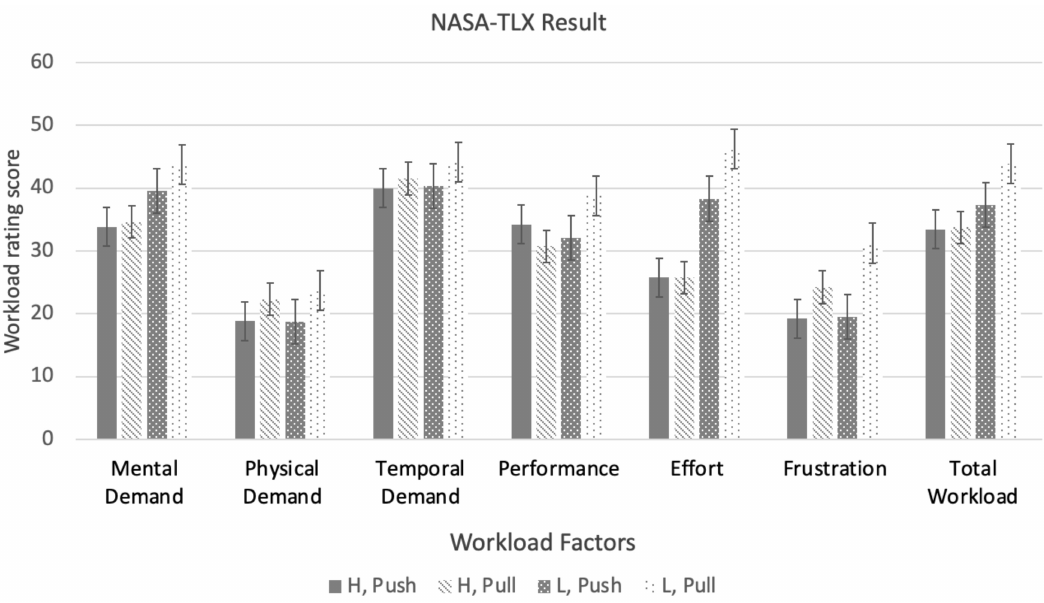
Figure 7. NASA/TLX Result [error bars indicate standard